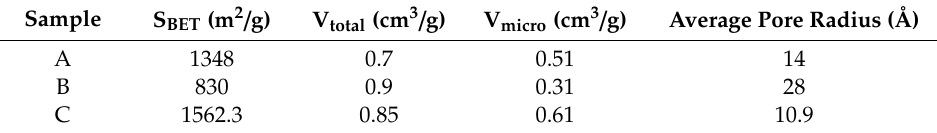
Table 3. Specific surface, area volume and pore distribution of copper